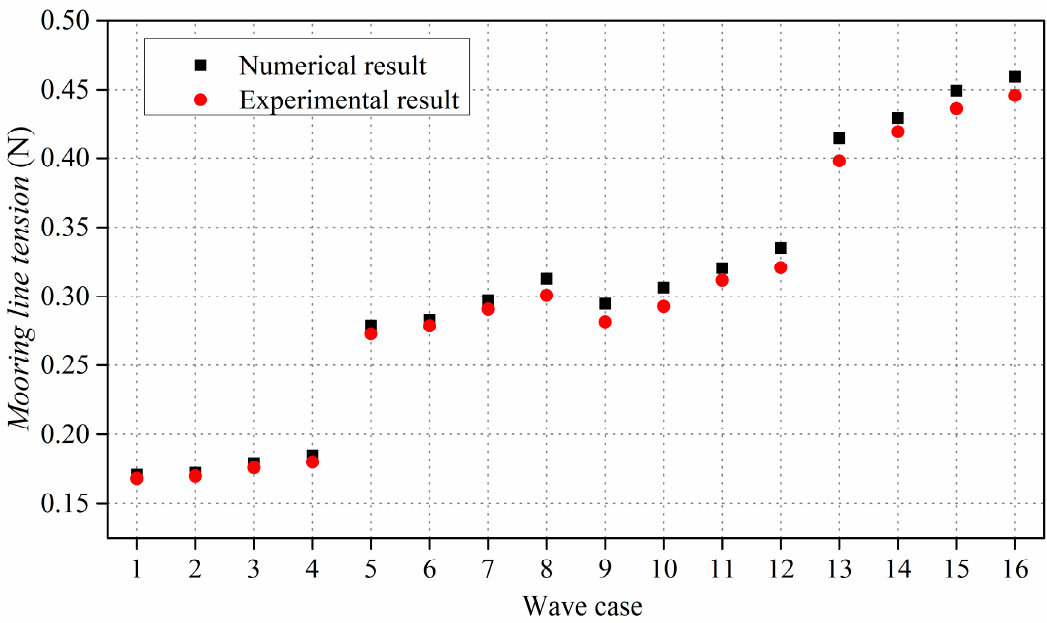
Figure 8. The comparison of peak value of mooring line tension between numerical simulations and experiment results.